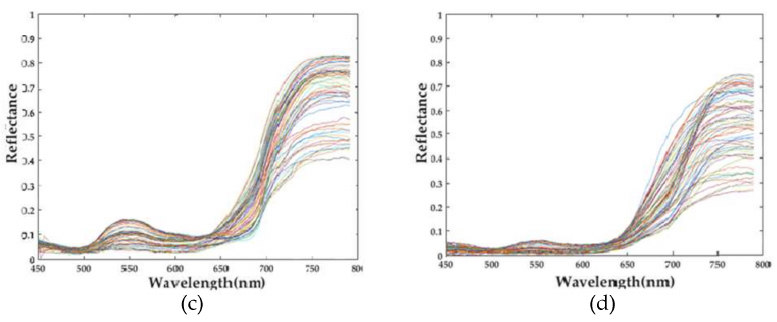
Figure 16. Spectral data of two plants with purple background. The upper sub-figures ( a , b ) show the spectra of two different sampling positions that correspond to the target and background respectively, while the lower sub-figures ( c , d ) display the spectra of all sampling